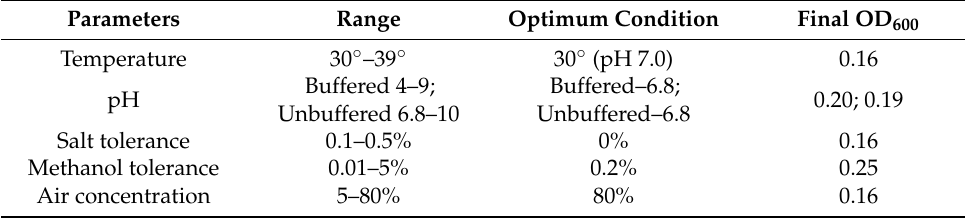
Table 2. Biochemical characterization of strain BlB1.